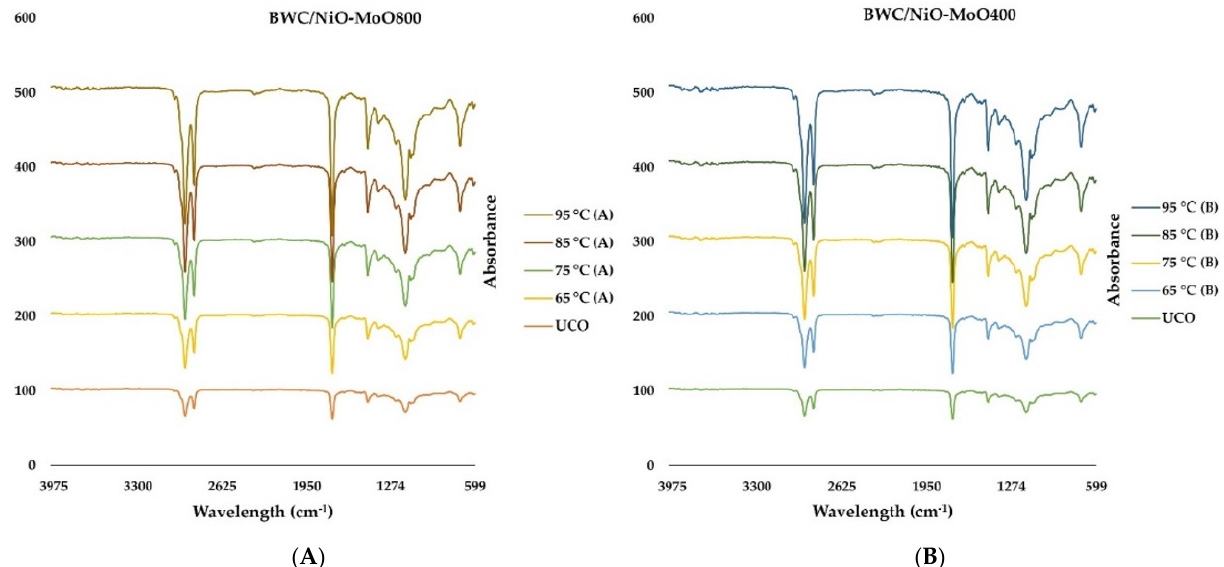
Figure 7. Chemical functional groups of triglycerides and transesterified products at ( A ) 800 °C and ( B ) 400 °C under FTIR analysis.